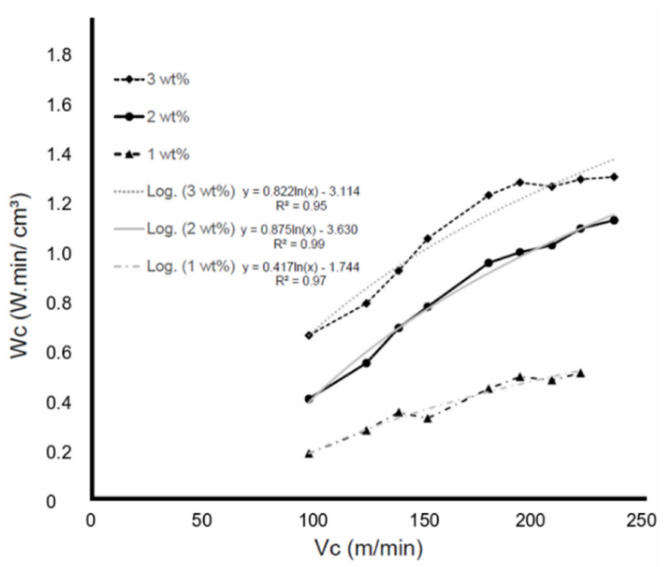
Figure 3. Specific cutting energy in relation with the cutting speed for various percentages of